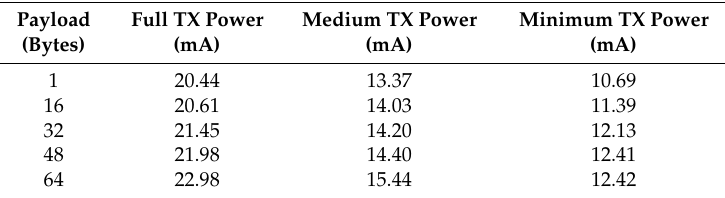
Table 4. Transmission current for several payloads.